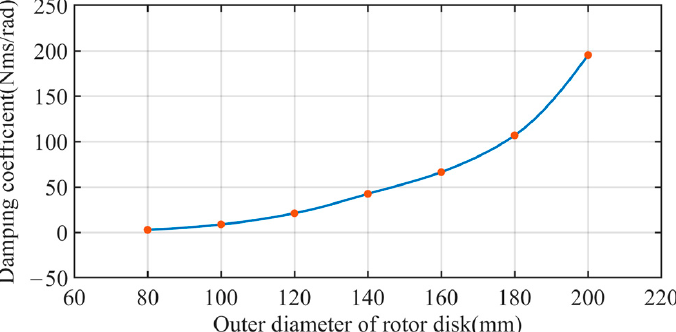
Figure 19. Distribution of damping coefficient with the outer diameter of rotor disk.